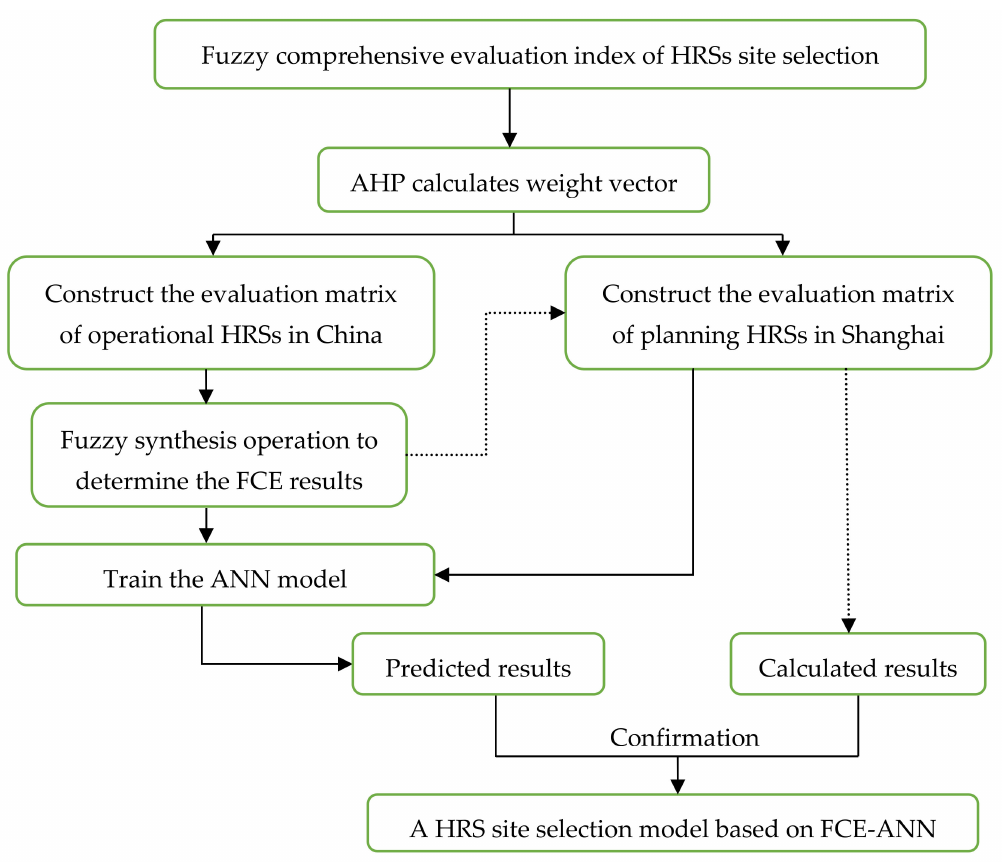
Figure 3. Research framework proposed in this